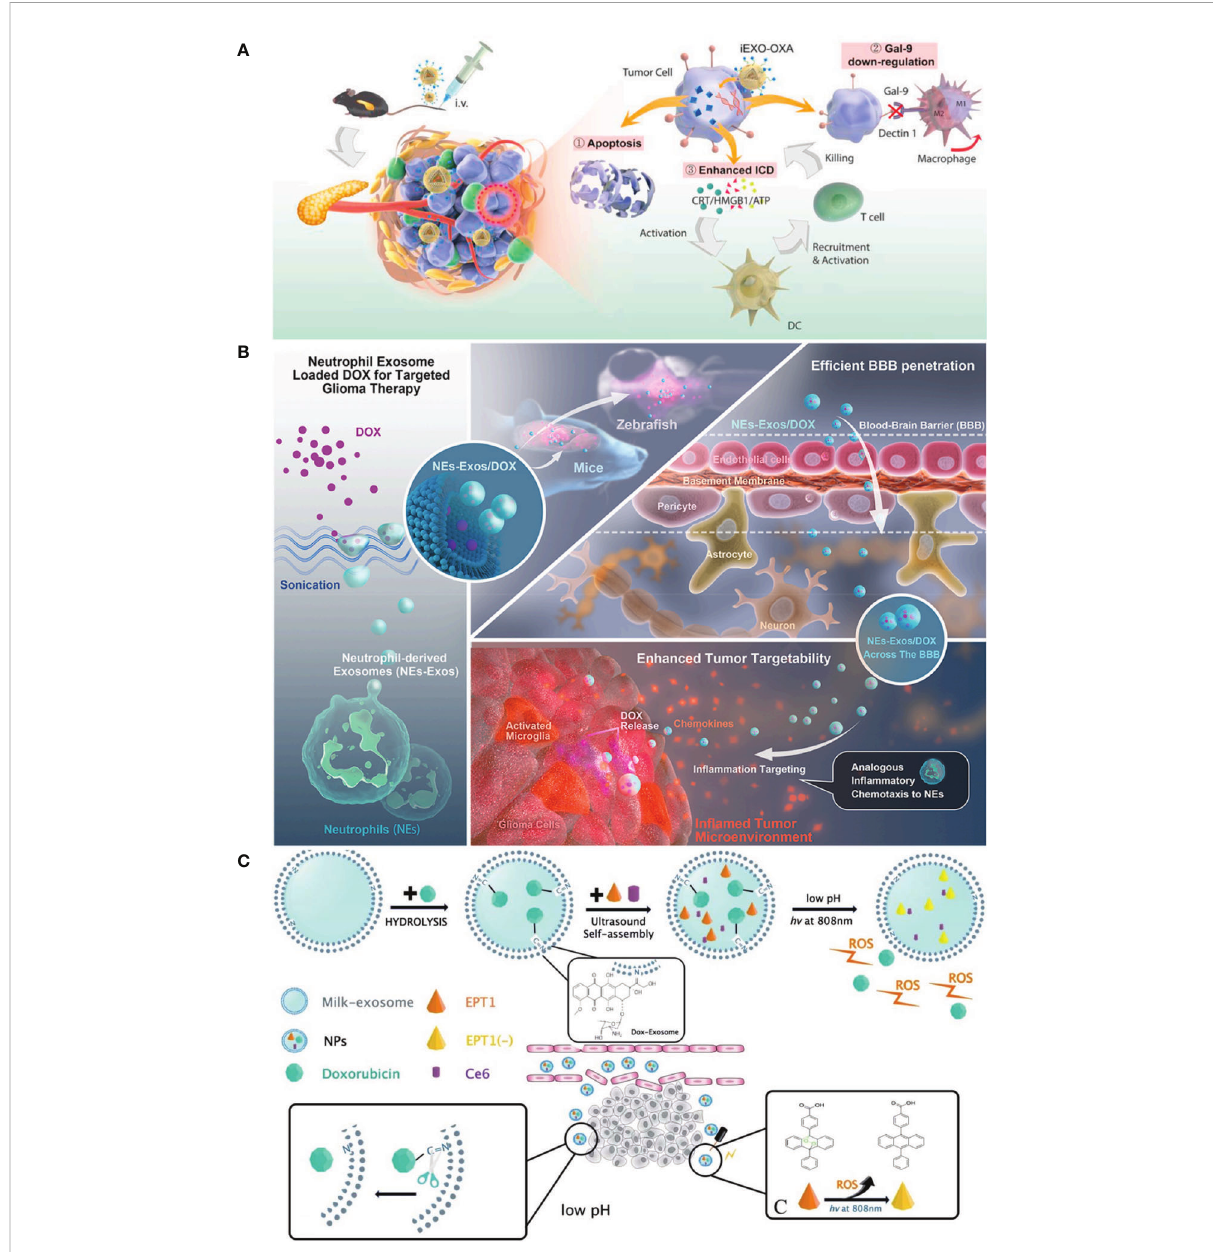
FIGURE 4 (A) Pancreatic-targeting exosomes-based dual delivery biosystem for pancreatic immunotherapy and reprogramming tumor microenvironment (Reprinted with the permission from Ref. 128); (B) The Scheme of NEs-Exos system for glioma immunotherapy (Reprinted with the permission from Ref. 147); (C) The preparation scheme and therapeutic process of Exo@DOX – EPT1 for oral squamous cell carcinoma (Reprinted with the permission from Ref. 136). iEXO-OXA, Exosomes losding oxaliplatin; ICD, immunogenic cell death; EPT1, Endoperoxide derivative; NPs, Nanoparticles; DOX, Doxorubicin; ROS, reactive oxygen; Ce6, Chlorin